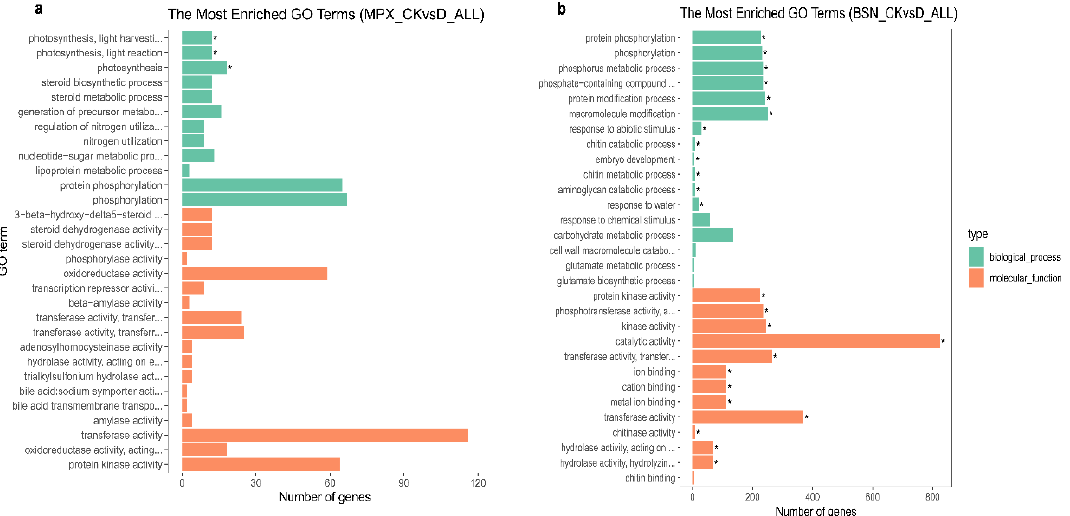
Figure 4. Histogram of GO enrichment of differential genes. Green indicates biological processes, and orange indicates molecular functions. Among them, the term is the basic unit of GO, and each term corresponds to a function, with “*” as the significantly enriched GO term. ( a ) Histogram of GO enrichment of differential genes in MPX treatment group and the control after 21 days of drought; ( b ) Similar to panel ( a ) but for the BSN